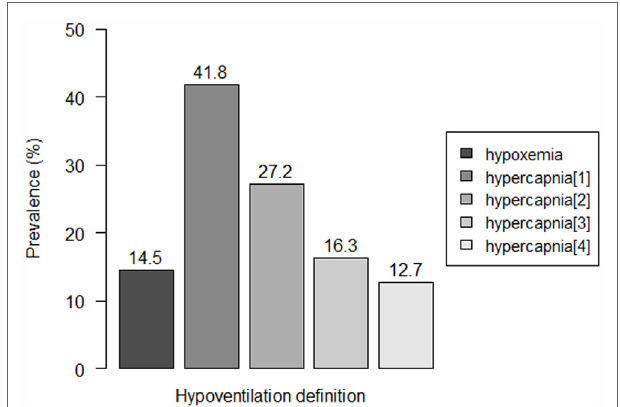
FigUre 1 | Prevalence of residual hypoventilation according to the different definitions . Hypoventilation definitions: “hypoxemia”: oxygen saturation (SpO 2 ) < 90% during ≥ 10% of the total recording time; “hypercapnia[1]”: peak transcutaneous CO 2 (TcCO 2 ) > 49 mmHg; “hypercapnia[2]”: TcCO 2 > 49 mmHg during ≥ 10% of the total recording time; “hypercapnia[3]”: peak TcCO 2 > 55 mmHg,